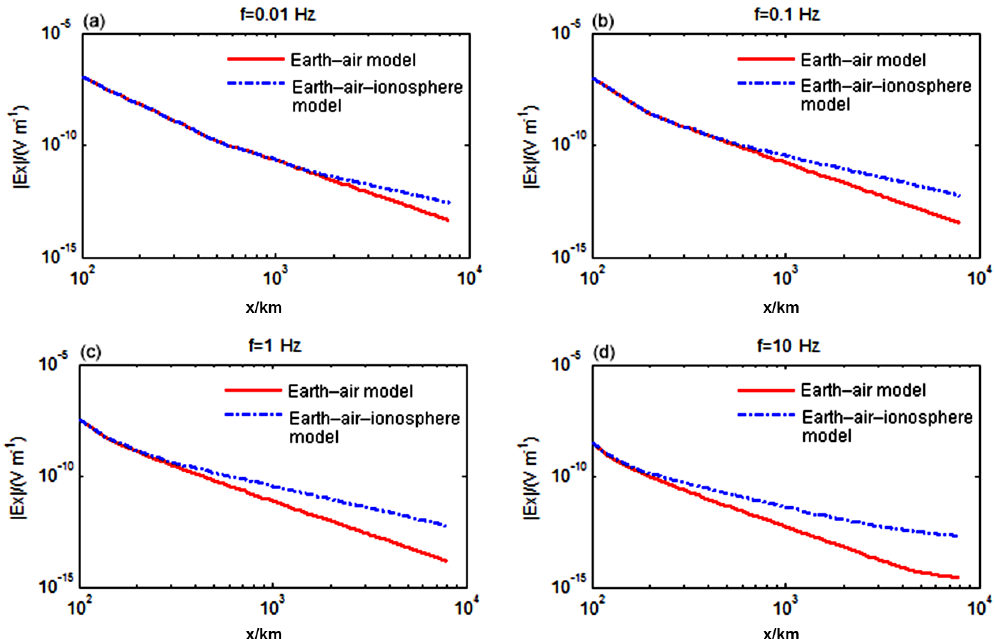
Figure 2. Electric field | E x | decay curves along x axial direction as a function of the observing distance for the Cartesian coordinate system with different frequencies. Red solid lines stand for electric field curves for the Earth–air model and blue dotted lines denote electric field curves with the ionospheric effect for the Earth–air–ionosphere model. (a) Total | E x | for f = 0.01Hz, (b) total | E x | for f = 0.1Hz, (c) total | E x | for f = 1Hz, and (d) total | E x | for f = 10Hz.